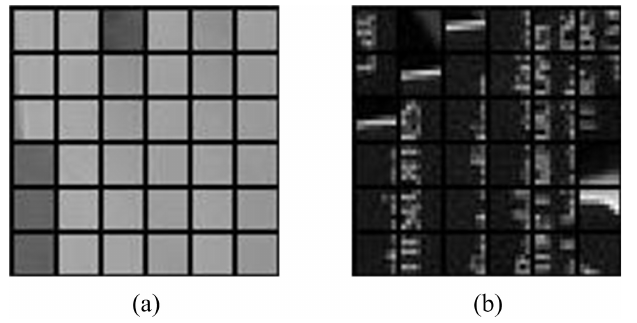
Figure 2. Smooth Image Patches and Non-smooth Image Patches, (a) shows smooth image patches, (b) shows non-smooth image